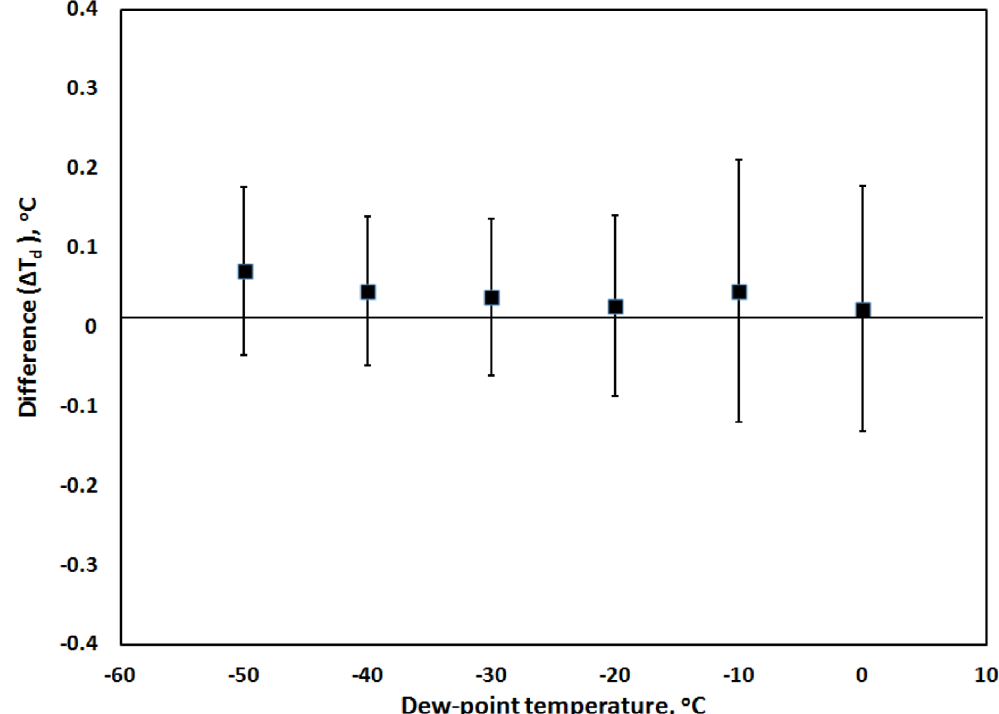
Fig. 3. Differences between the two generators ( D T d = T d(1-T) (cid:1) T d(2-T) ), measured using chilled-mirror hygrometer, with the pair uncertainty ( k